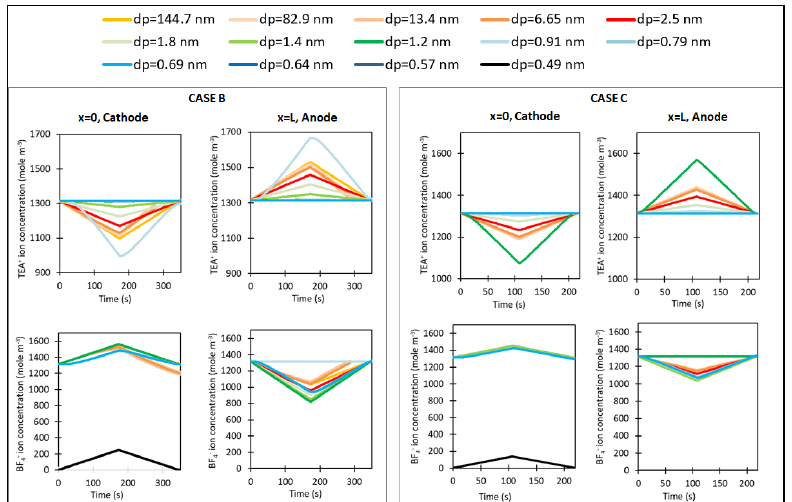
Figure 7. Predicted ion concentration profiles against time at x = 0 (cathode/current collector) and x = L (anode/current collector) for AC coating electrodes and Case B: 1.5 M TEABF 4 /AN electrolyte and Case C: 1.5 M TEABF 4 /PC electrolyte.